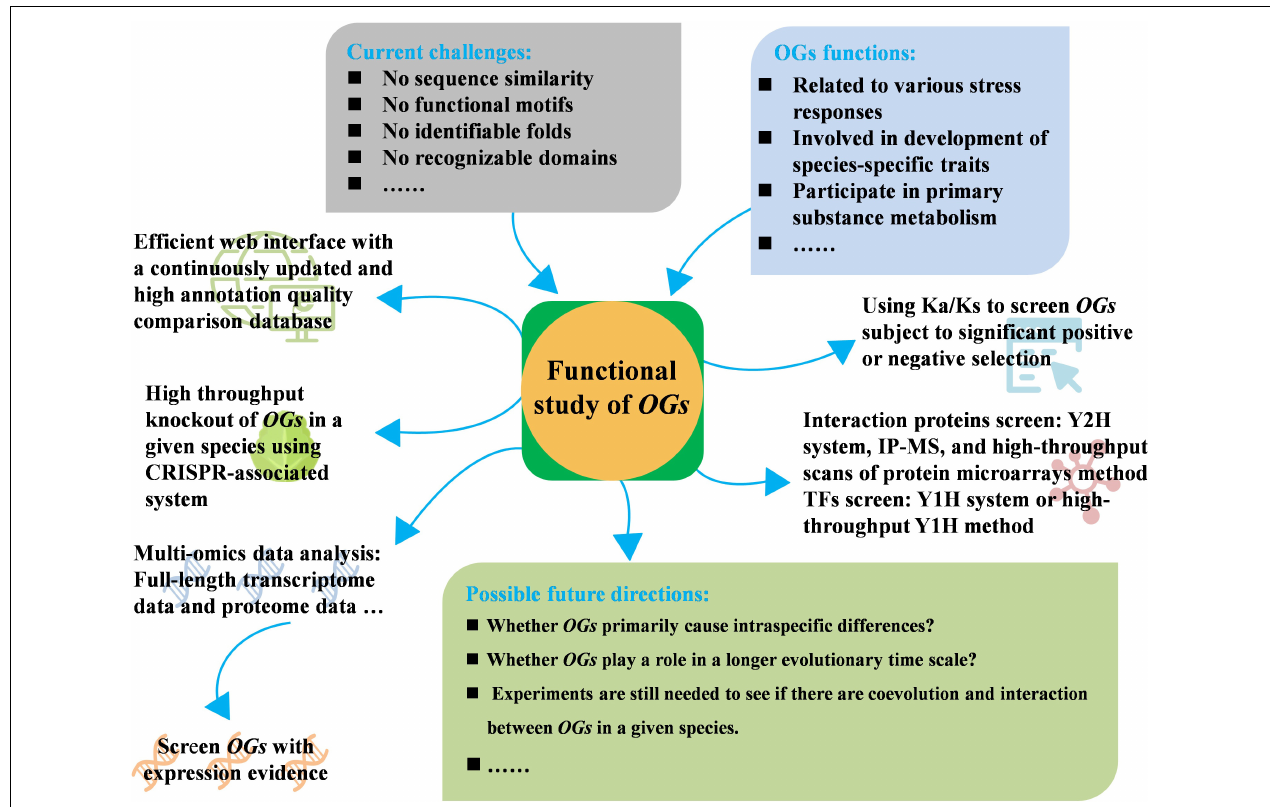
FIGURE 1 | Current challenges, adoptable strategies, and possible future directions of functional study of orphan genes ( OGs